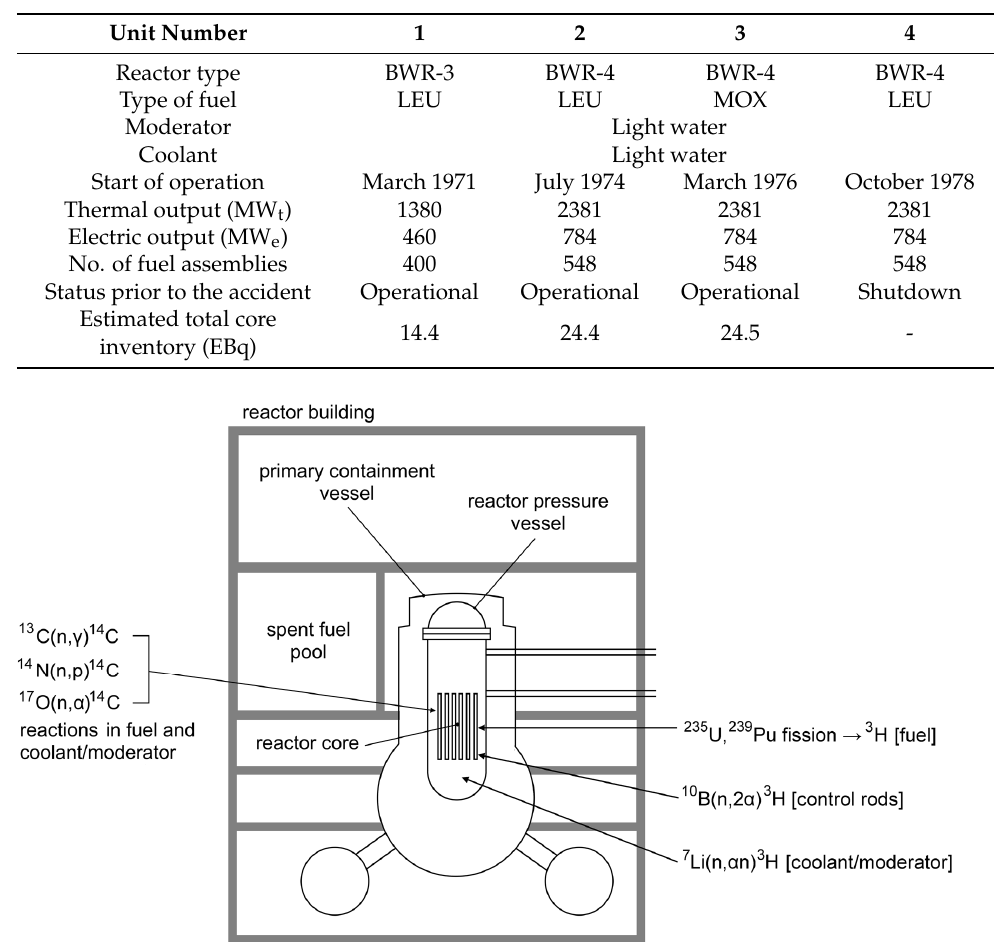
Figure 1. Simplified scheme of a boiling water reactor (BWR) operated at the FDNPP with the typical production pathways of 3 H and 14